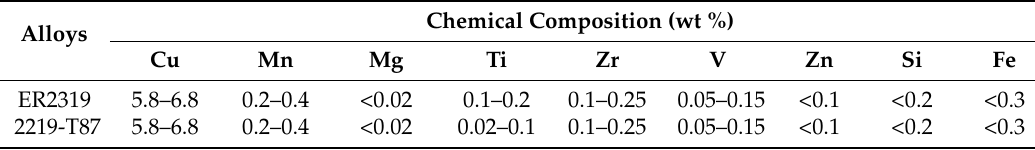
Table 1. Nominal composition of ER2319 wire and the 2219-T87 substrate.